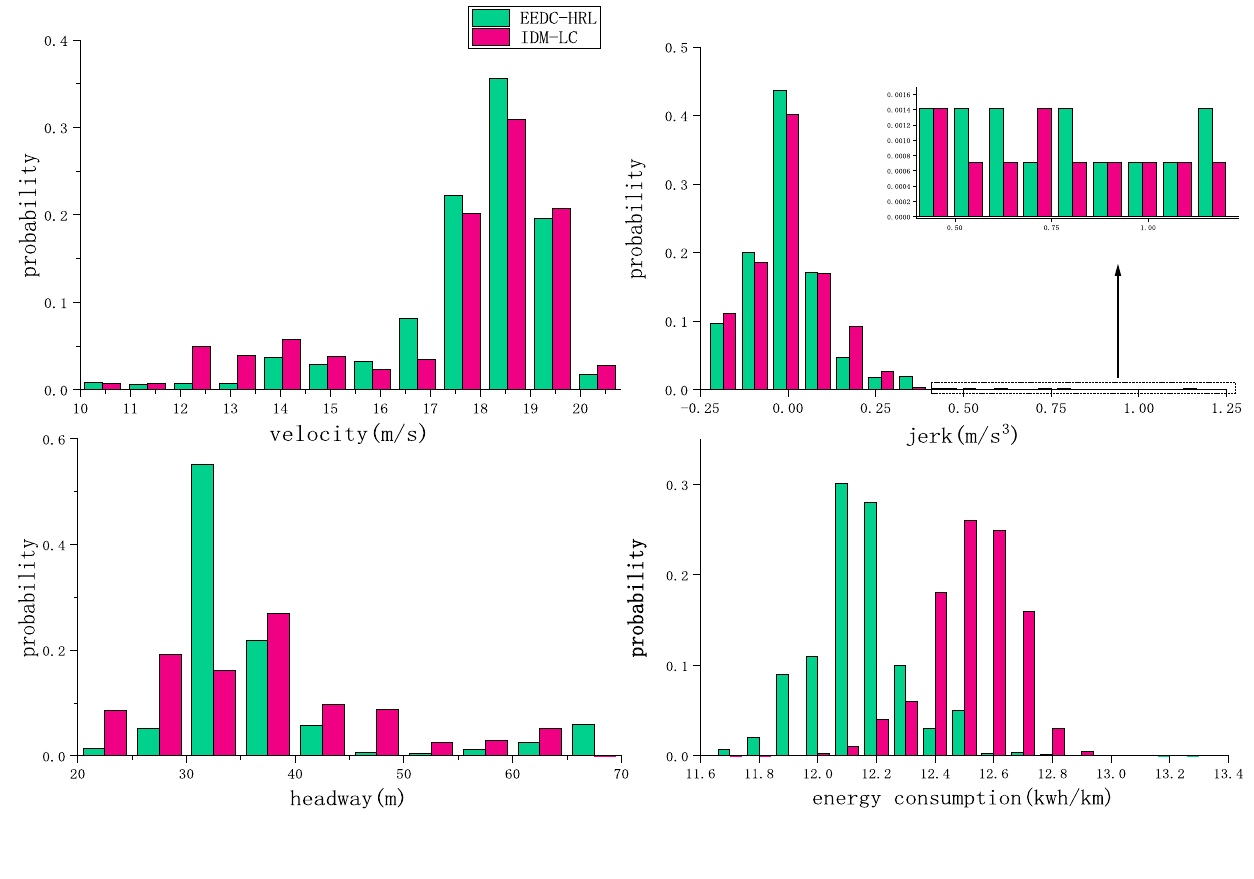
Figure A1 The data distribution of each performance indicator in the free traf fi c fl